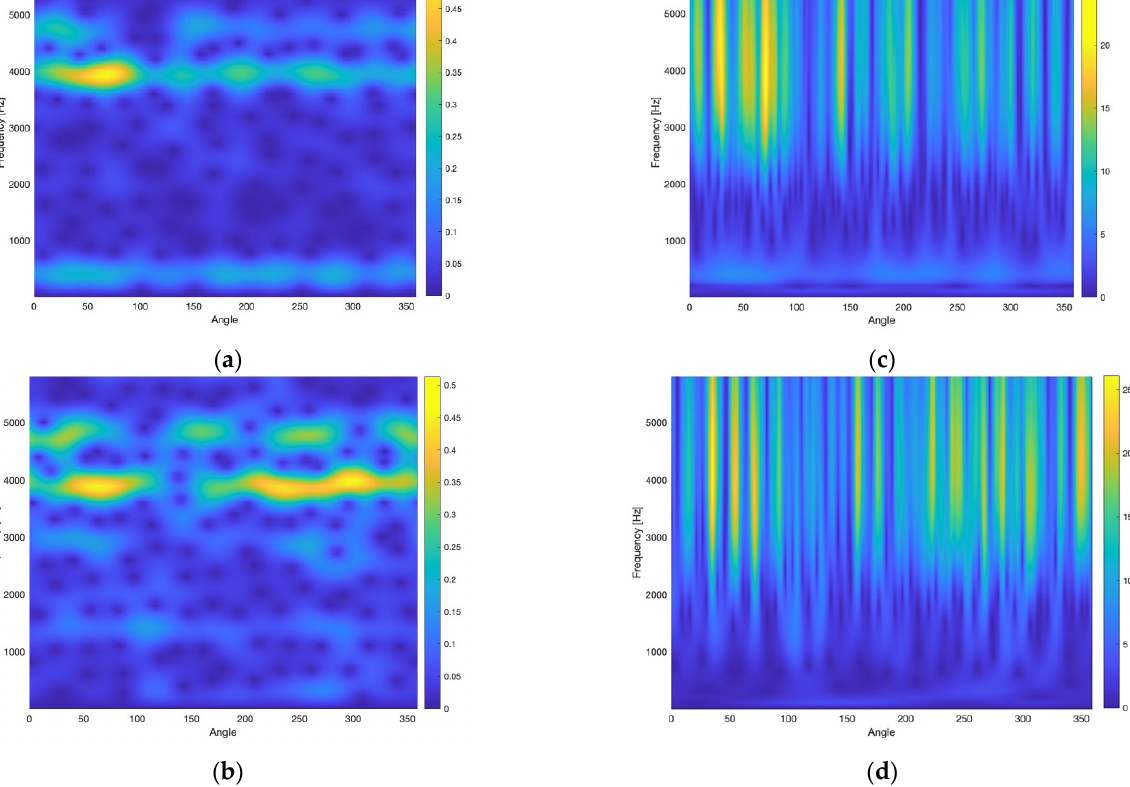
Figure 5. The wavelet scalograms of the vibration signal, originating from the faultless gearbox ( a ) and the faulty gearbox ( b ), obtained by the Morlet wavelet function, reprinted from ref. [59]. ( c , d ) are the scalograms of the same signals, originating from the faultless gearbox and the faulty gearbox, respectively, that are obtained by the Mexican hat wavelet function.